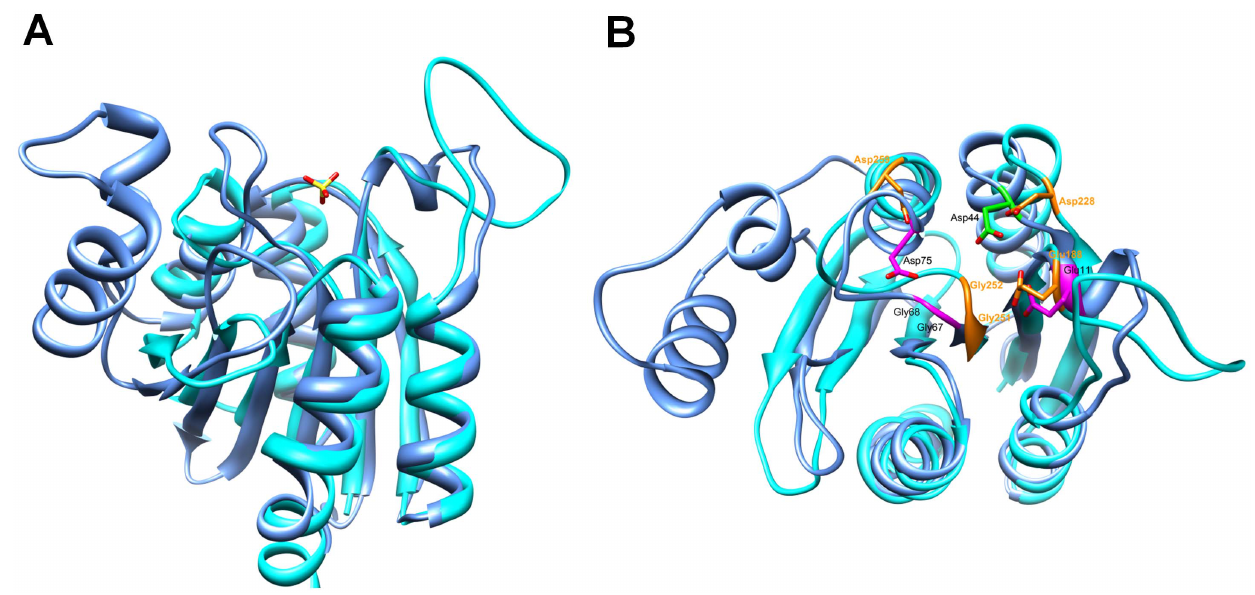
Figure 9. Structural comparison of Thermoplasma acidophilum COG1058 and E. coli MoeA enzymes. A) Ribbon representation of superposed T. acidophilum COG1058 (blue) and E. coli MoeA (cyan) structures. The sulfate ion found in the COG1058 structure, likely indicative of the position of the active site, is shown as ball and stick; B) Superposed COG1058 and MoeA structures viewed from the top. The MoeA acidic residues predicted to be involved in catalysis and the two glycines of the conserved motif proposed to interact with the phosphate moiety of the MPT substrate are highlighted in orange, and their superposition to identical residues in the COG1058 structure is shown.